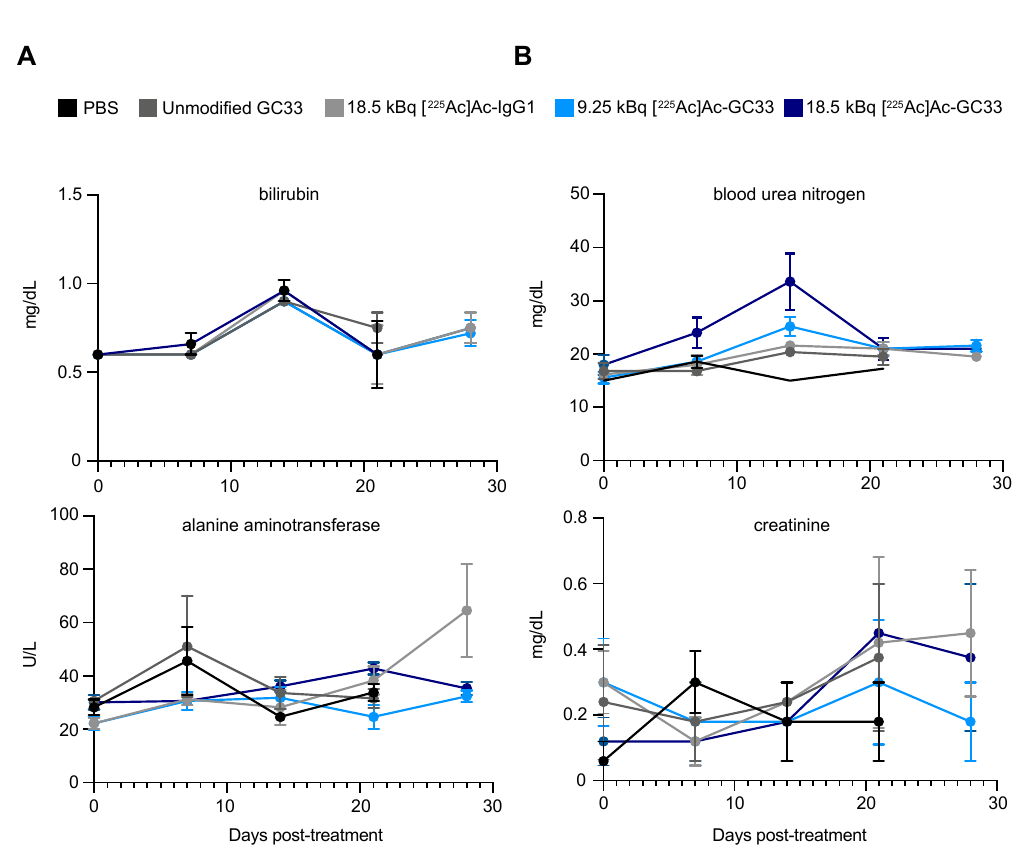
Figure 5. Markers of liver and kidney function are stable following treatment with radioimmunoconjugates. ( A ). Markers of liver damage, bilirubin and alanine aminotransferase. ( B ). Markers of kidney function, blood urea nitrogen and creatinine exhibit minor changes following treatment compared with control-treated groups, suggesting that toxicity to liver and kidneys is limited. Error bars represent the standard error of the mean (SEM).